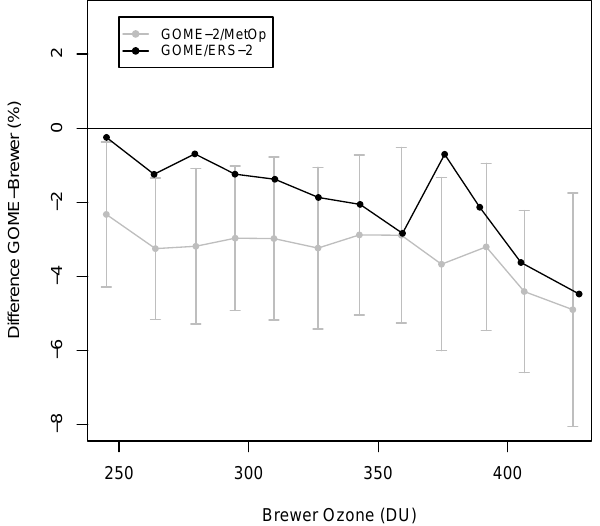
Fig. 5. Variation of GOME-Brewer relative differences with Brewer ozone measurements for the “Iberian Peninsula” dataset.